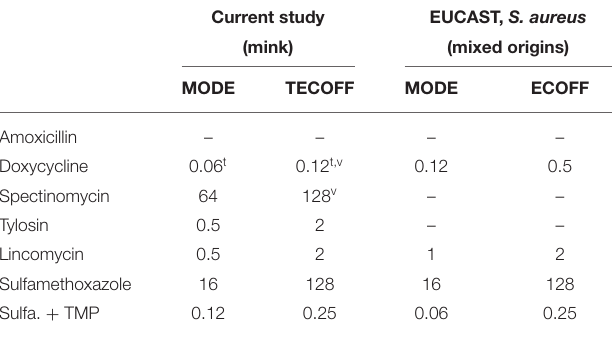
TABLE 3 | Staphylococcus delphini isolated from mink—tentative ECOFFs and modes of MIC wildtype distributions, compared with modes and ECOFFs for S. aureus from EUCAST.